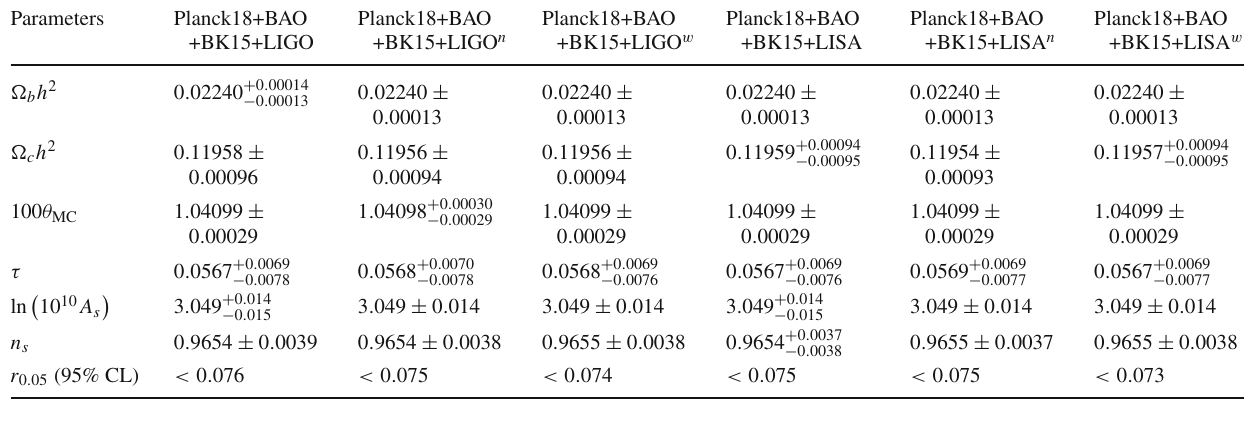
Table 2 The 68% limits on the cosmological parame- ters in the (cid:2) CDM+ r model from the combinations of Planck18+BAO+BK15+IPTA, Planck18+BAO+BK15+IPTA n ,